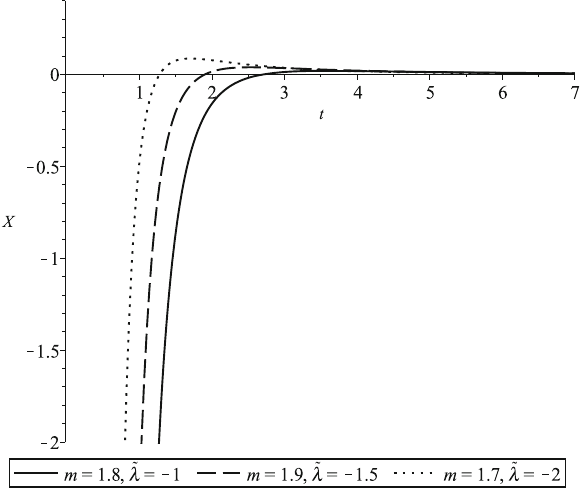
Fig. 4 F ( t ) for different values of ˜ λ < 0 and m >